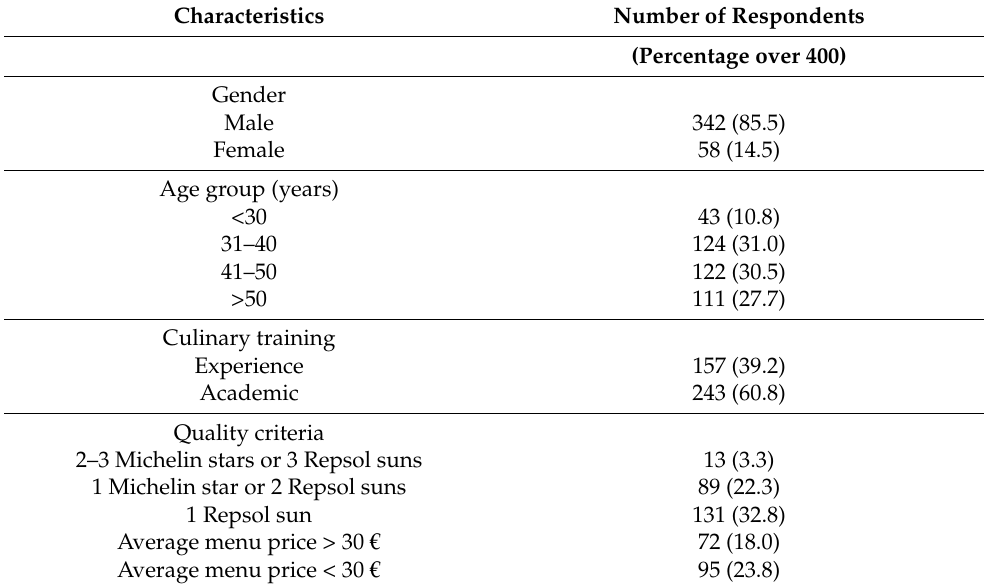
Table 1. Profile of